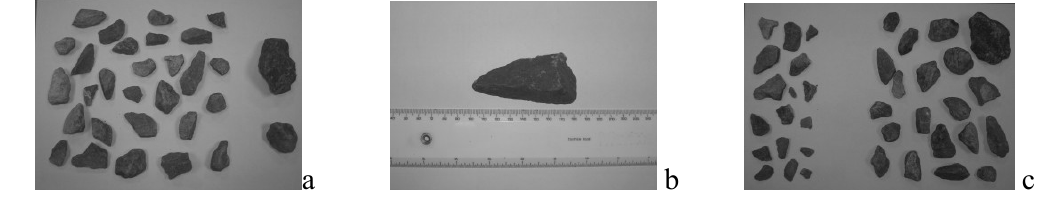
Figure 1. Selection of random stones collected on the